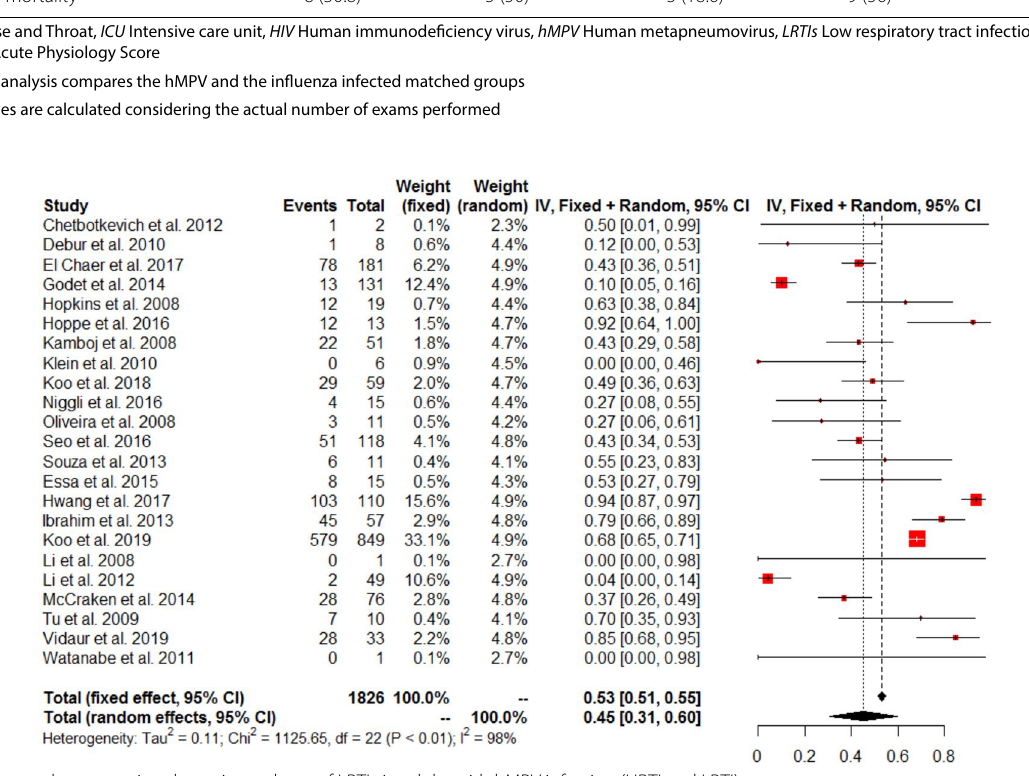
Fig. 3 Forest-plot presenting the estimated rate of LRTIs in adults with hMPV infection (URTI and